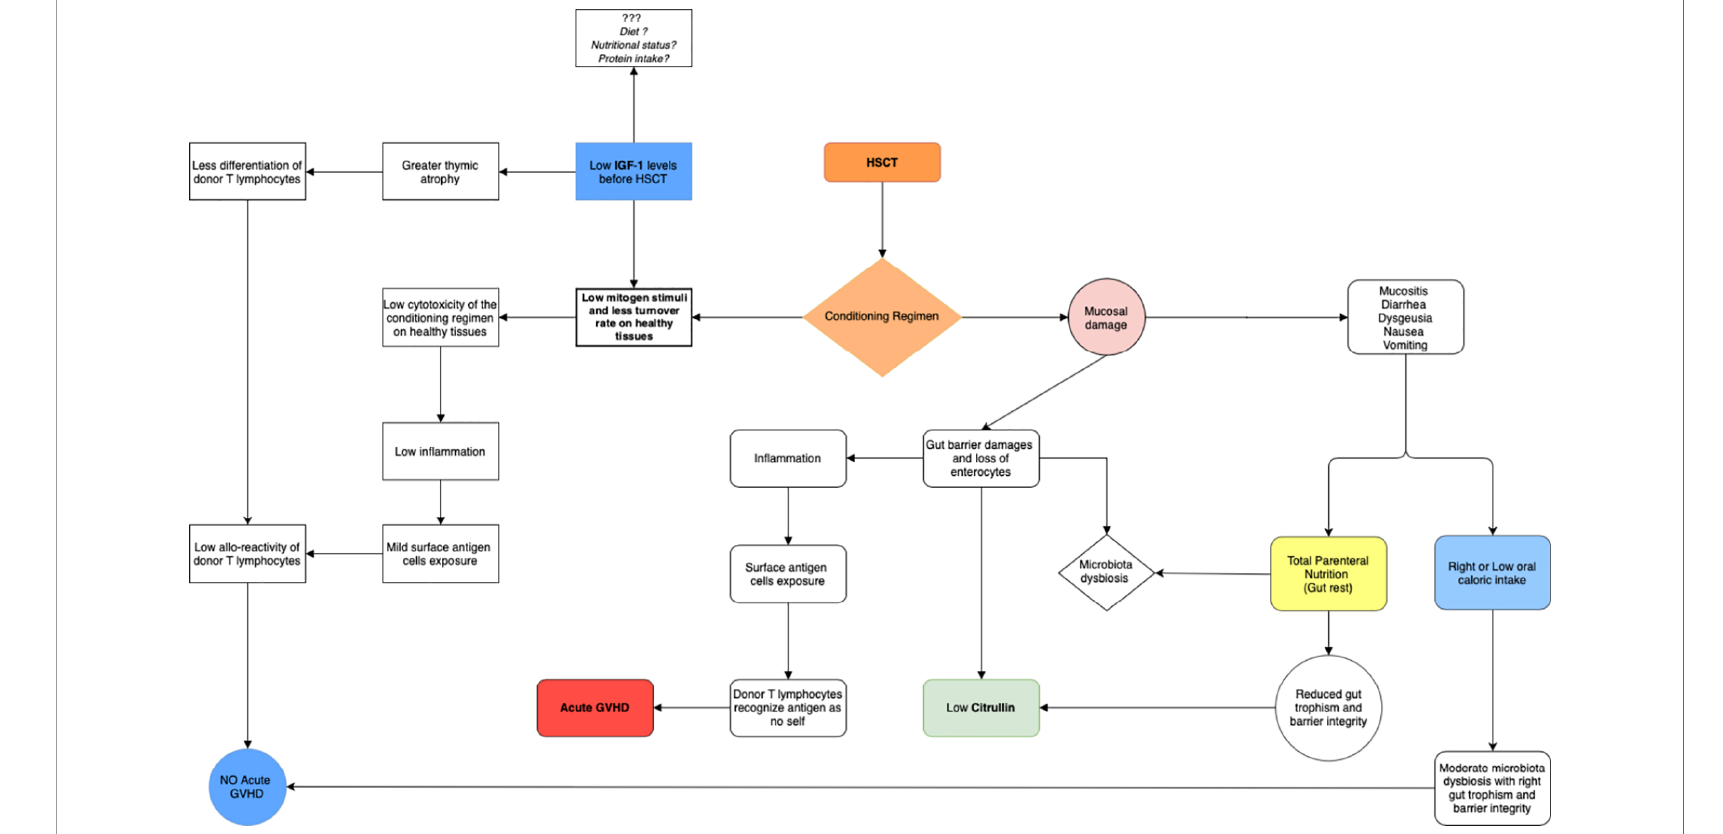
FIGURE 3 | Shows the possible role of IGF-1 in the development of acute GVHD and the possible role of citrulline in demonstrating the presence of mucosal damage. The conditioning regimen causes a mucosal and gut barrier damage. Gut toxicity has a huge impact on nutritional status. Mucosal and gut barrier damage could be evaluated by plasma citrulline levels: a biomarker of gut barrier damage. Insulin-like growth factor-1 (IGF-1) is the major mediator of growth hormone (GH), as well as a mediator of GH-independent anabolic responses in many cells and tissues. Low levels of IGF-1 in pre-transplant period, seems to be associated with a lower risk of acute GVHD: a low mitogen stimuli on healthy tissues, mediated by low IGF-1 levels, could reduce damages and tissues in fl ammation mediated to chemotherapy, but this hypothesis should be con fi rmed by larger